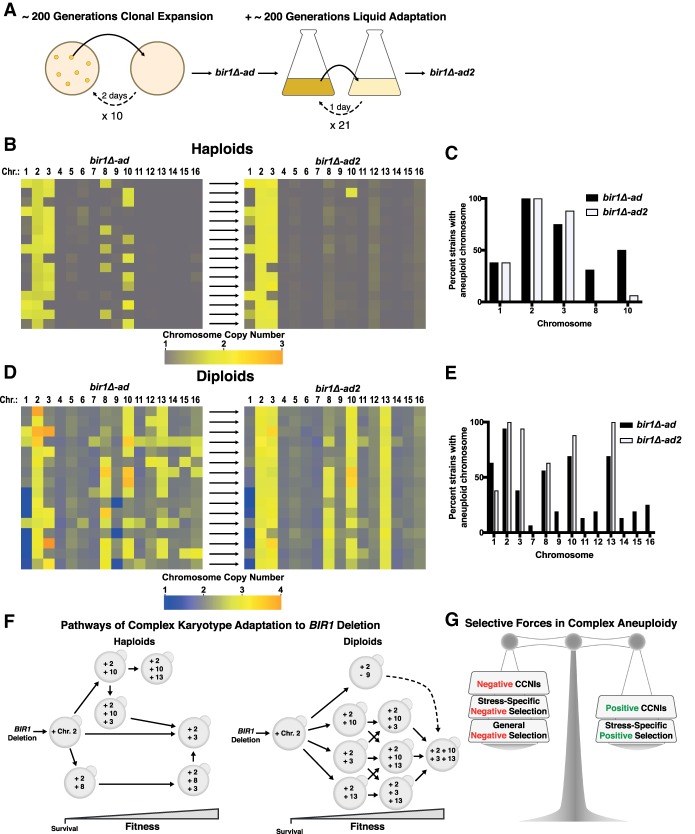
Additional adaptation leads to convergence on “ideal” karyotypes in BIR1 deletion strains. (A) Graphical representation of the adaptation process on solid (see Fig. 1A) followed by liquid medium. On solid medium, the bir1Δ strains were struck out for single colonies and allowed to grow for 2 d at 30°C. After 10 rounds of growth on solid medium, a subset of bir1Δ-ad strains, selected to represent a diverse set of karyotypes, was grown for an additional ∼200 generations in liquid medium. Liquid cultures were diluted each day for 21 d, generating further adapted haploid/diploid bir1Δ-ad2 strains. (B) Heat map visualization of chromosome copy number values for the haploid bir1Δ strains before (see Fig. 1C) and after adaption in liquid medium. The bir1Δ-ad strains at the left directly correspond to the bir1Δ-ad2 strains at the right. (C) Frequency of aneuploidy for each chromosome in the haploid bir1Δ-ad and bir1Δ-ad2 strains based on binarization of the data in B. (D) Heat map visualization of chromosome copy number values for the diploid bir1Δ strains before (see Fig. 5A) and after adaption in liquid medium. The bir1Δ-ad strains at the left directly correspond to the bir1Δ-ad2 strains at the right. (E) Frequency of aneuploidy for each chromosome in the diploid bir1Δ-ad and bir1Δ-ad2 strains based on binarization of the data in D. (F) An empirical model depicting the pathways of adaptation to BIR1 deletion based on synthesizing data from Figures 1, 2, 3, and 5 and this figure. Adaptation starts with the gain of chromosome 2, which appears to be essential for initial survival. Following chromosome 2 gain, many different possible paths can be taken by haploid and diploid yeast during the formation of complex karyotypes. Note that some chromosome aneuploidies (disomy of chromosome 10 in haploids and monosomy of chromosome 9 in diploids) provide a growth advantage early in adaptation but must become euploid again to achieve the “optimal” complex karyotype. (G) Illustration of the selective forces that determine whether the aneuploidy of a chromosome is advantageous.